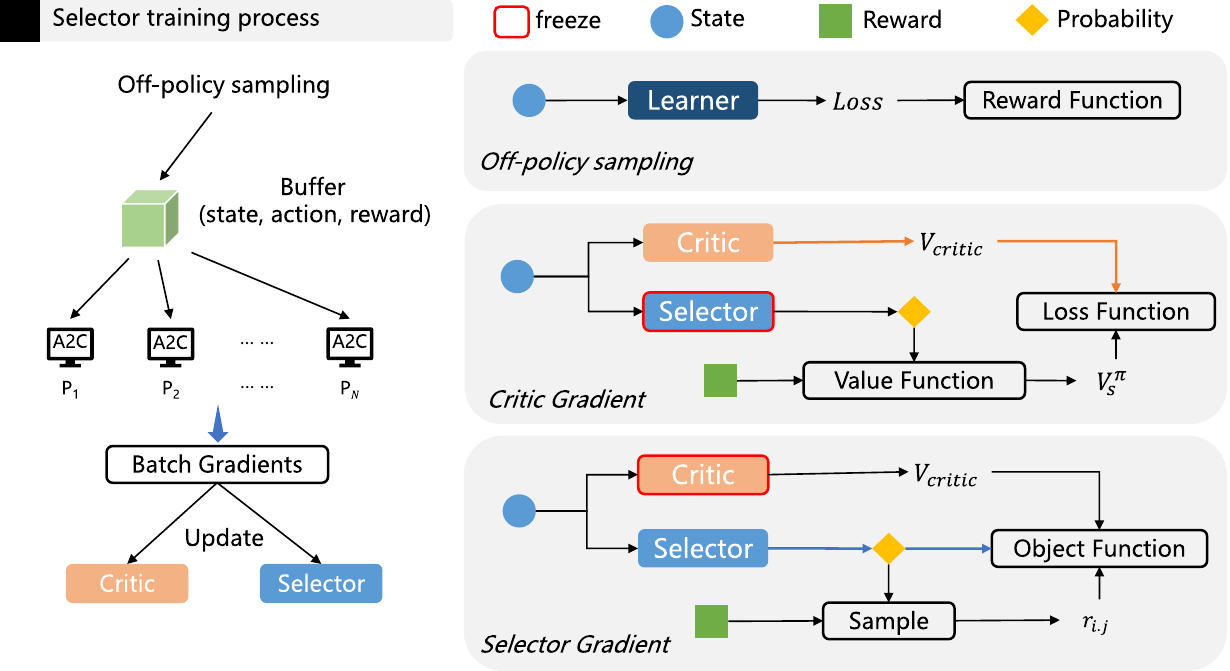
Figure 4. Selector training process based on asynchronous advantage actor-critic (A3C) framework. Selector